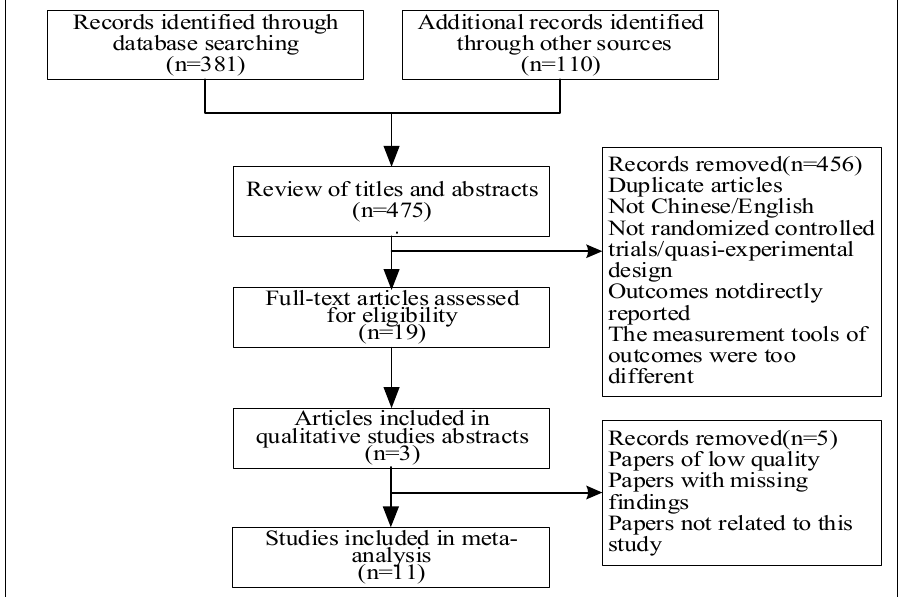
Figure 1. Flow chart of document selection and inclusion.